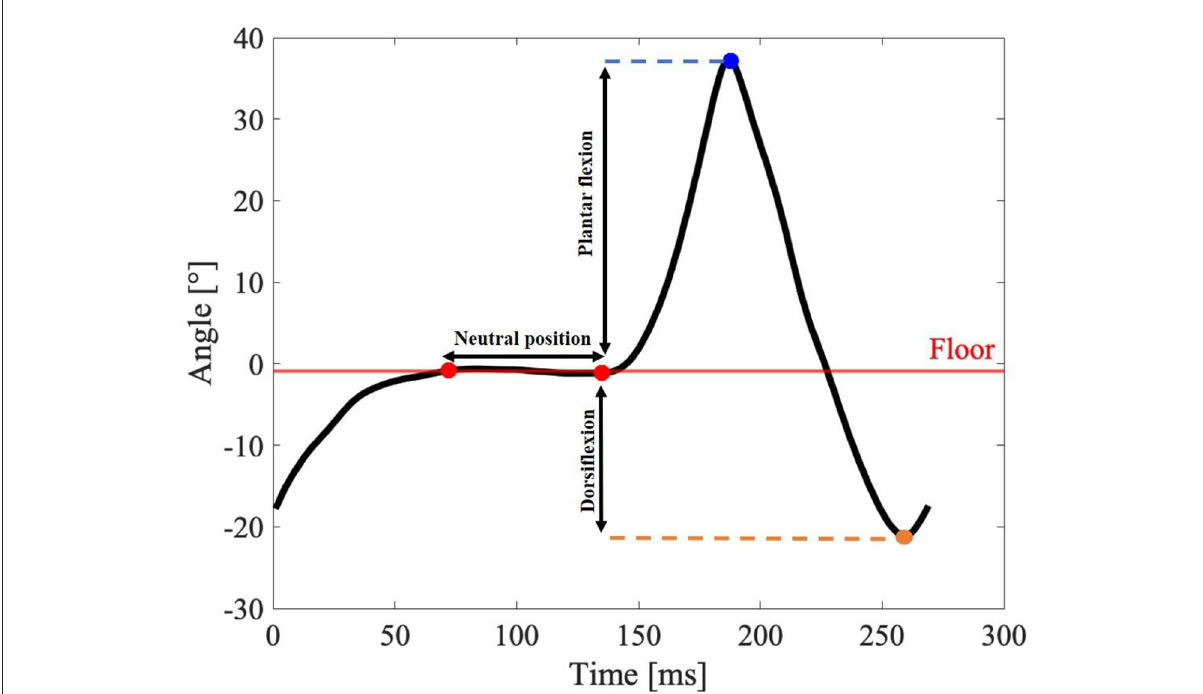
FIGURE7 Illustrative ankle range of motion of volunteer N1. Obtaining the amplitude of the dorsiflexion movement during the execution of a step, with detection of the neutral position demarcated by the red dots and the maximum amplitude of the movement demarcated by the blue dot. The green dot refers to the plantar flexion